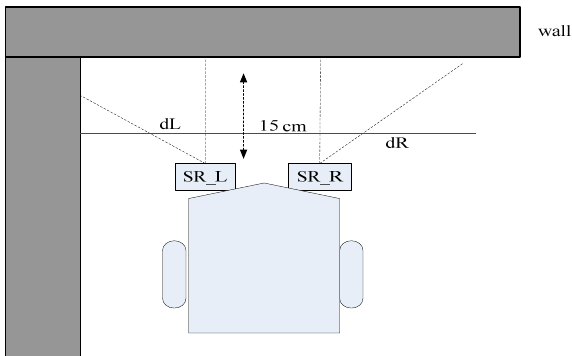
Figure 10. Sensors and input variables of the WMR [17].